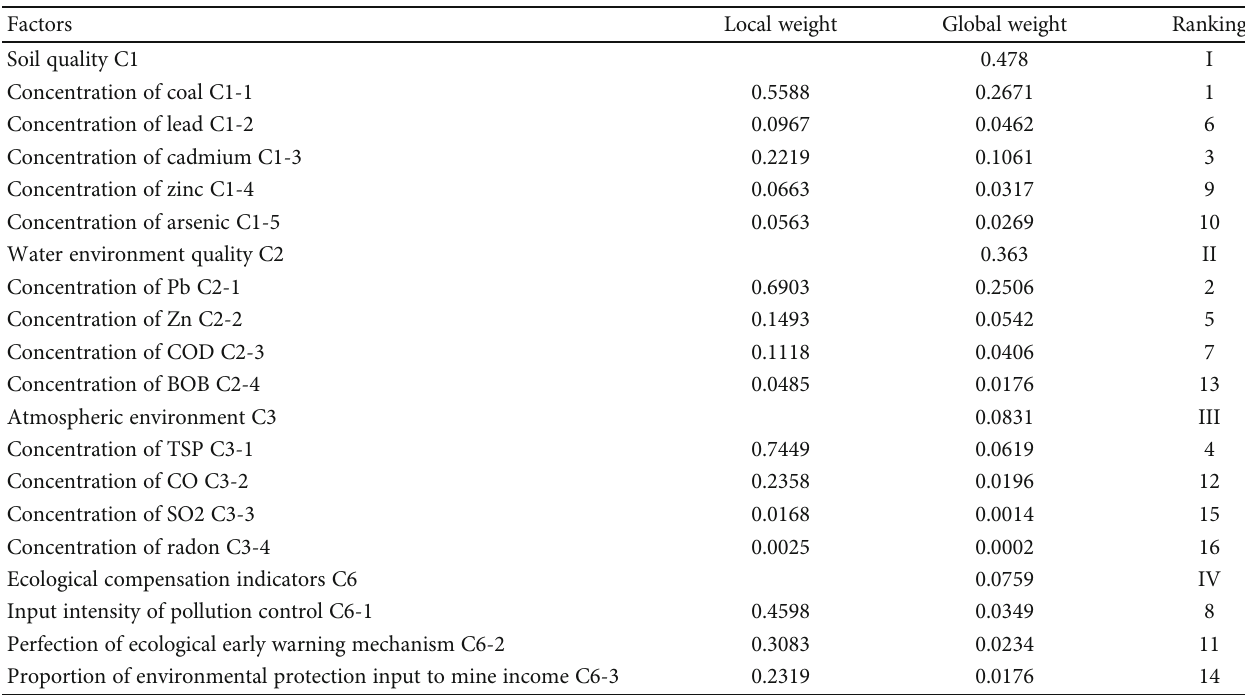
Table 13: The priorities of risk factors to the coal mine